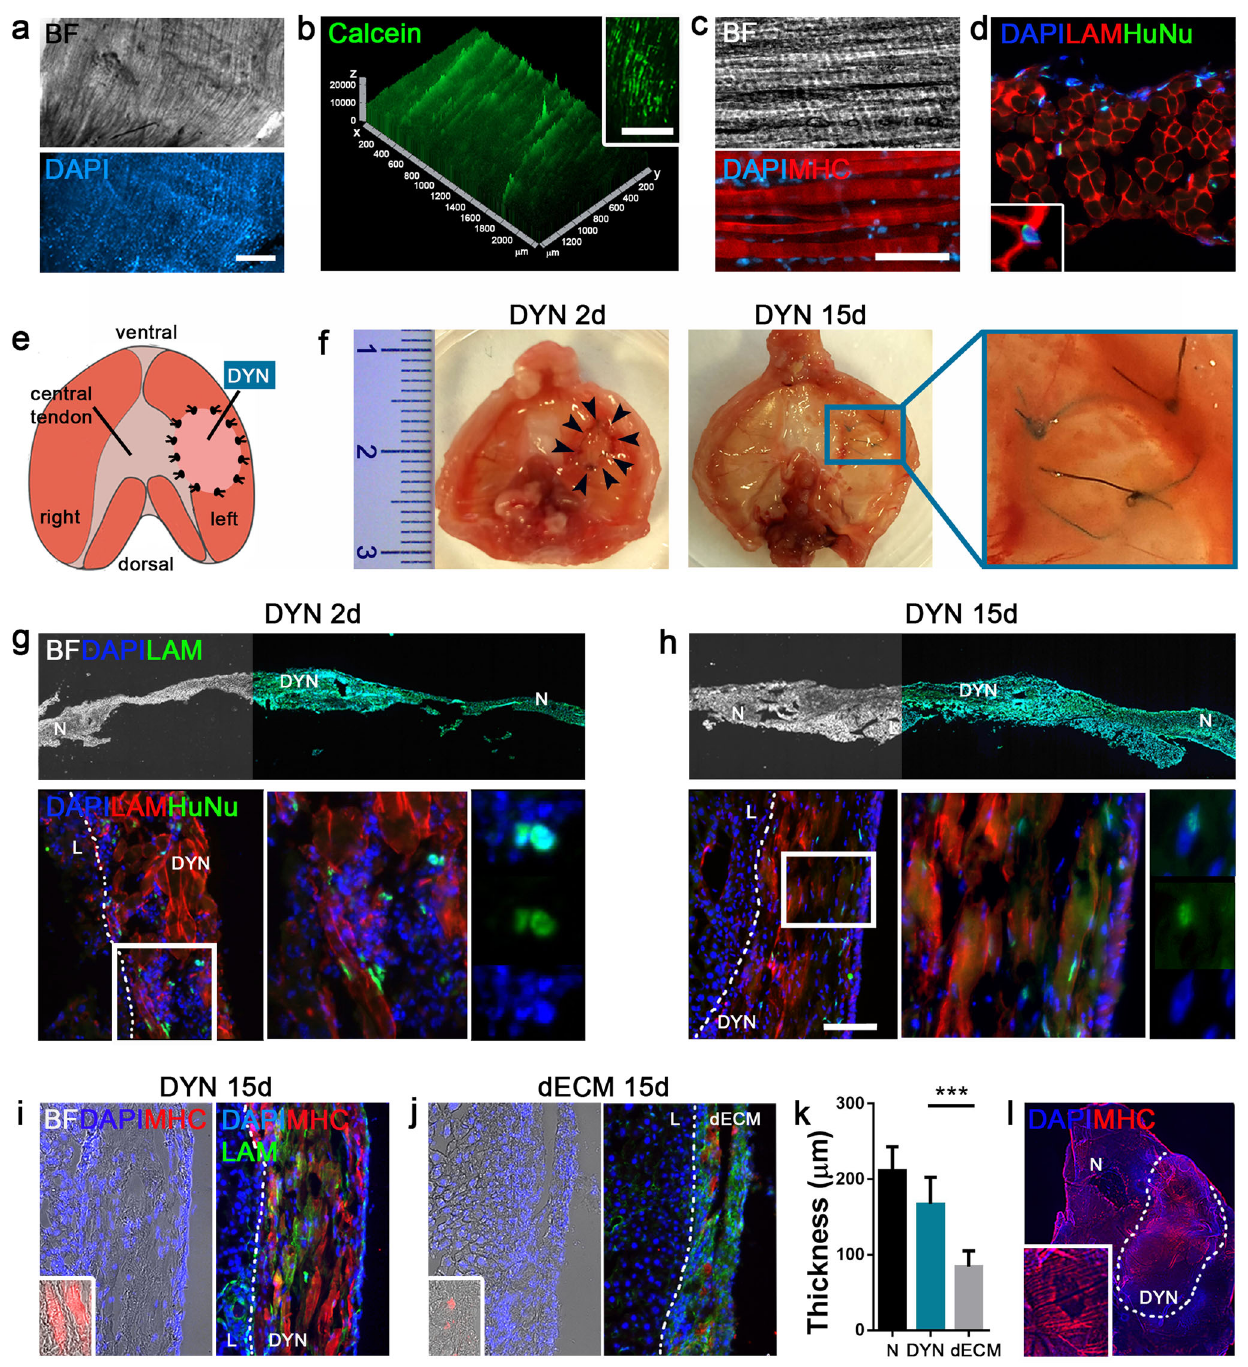
Fig. 6 In vivo implantation of dynamic construct in CDH mouse model. a Representative images of implanted patch (BF: bright fi eld). b Calcein staining to detect cell metabolic activity. c MHC staining of implanted construct. d Representative staining of human nuclei (HuNu) for the speci fi c detection of human cells. e General scheme of surgically induced CDH mouse model (abdominal view of mouse diaphragm). f Gross appearance of treated diaphragms after 2 and 15 days of implantation (scale bar: 1 cm). g , h Representative images of treated diaphragms after 2 and 15 days (scale bar: 500 μ m), with detection of HuNu-positive cells inside construct myo fi bers. Scale bars: 100 μ m. i – k Representative images of DYN and dECM implants after 15 days, with quanti fi cation of implant thickness ( n = 3 per group; 10 random high-powered fi elds per sample; mean ± s.d.). Scale bar: 100 μ m; scale bar inlet: 50 μ m. l Representative image of MHC expression on treated diaphragm. Scale bar: 500 μ m. *** p < 0.001. L liver, N native diaphragm, DYN dynamic construct, dECM decellularized 1 and plays a critical role in the pathogenesis of many samples displayed enrichment of the TGF β signaling pathway myopathies 64 . after 14 days. TGF β regulates the phenotype and function of fi broblasts and plays a role in myo fi broblast trans-differentiation; From a myogenic perspective, the slow and gradual mechanical it enhances the synthesis of matrix proteins such as Collagen type stimulation mimicked embryonal muscle development 65 . This